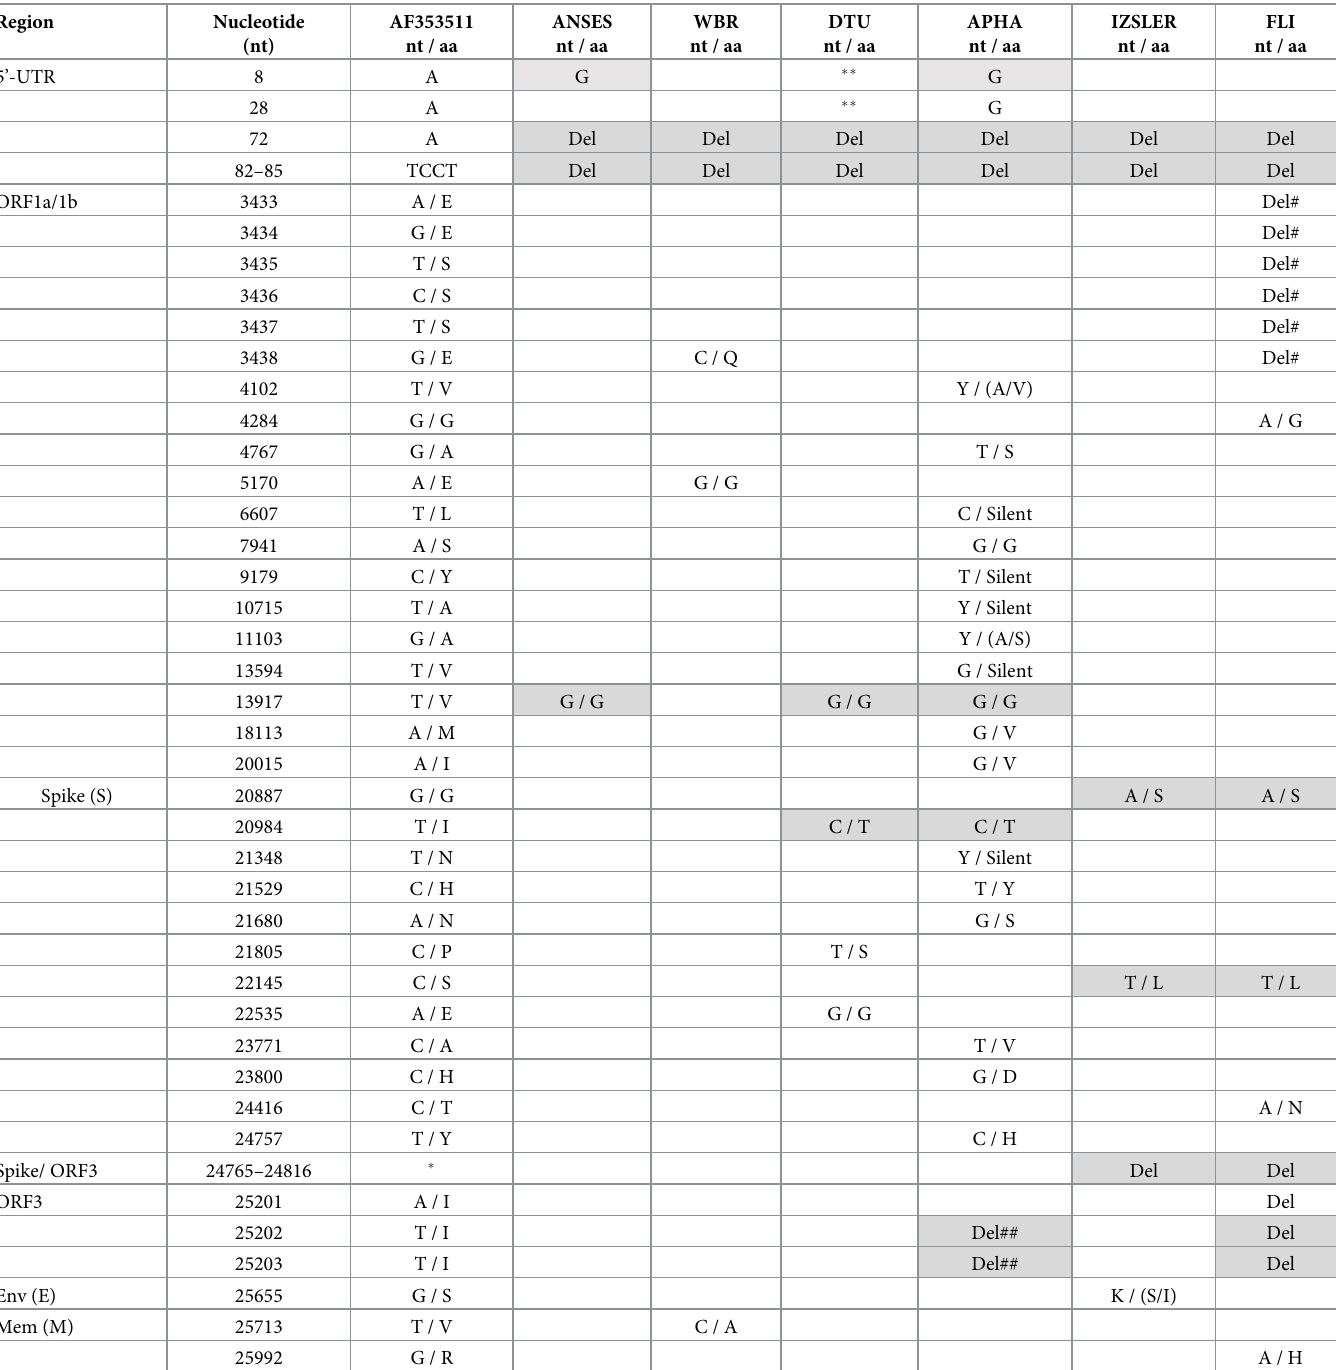
(cid:3) 52 nt deletion at Spike/ORF3 junction: TTTTGAAAAGGTCCACGTGCAGTG ATG TTTCTTGGACTTTTTCAATACACGA . Stop codon of Spike and start codon of ORF3 indicated with underline and italics, respectively. (cid:3)(cid:3) the 5´-terminal region of the Br1/87 (DTU) sequence is rearranged upstream of nt 35. #The 6 nt deletion modifies 3 codons and results in alteration of the encoded amino acid sequence from..NVESEV.. to..NVEV.., i.e. 2 amino acids are deleted. ## The loss of 2 nt results in the formation of a new termination codon that is predicted to result in the truncation of the ORF3 protein (see text for details). Shared changes are highlighted in grey. Synonymous nt changes are indicated as “silent”. The nt identifier Y is for pyrimidines (C or T) while K denotes G or T.